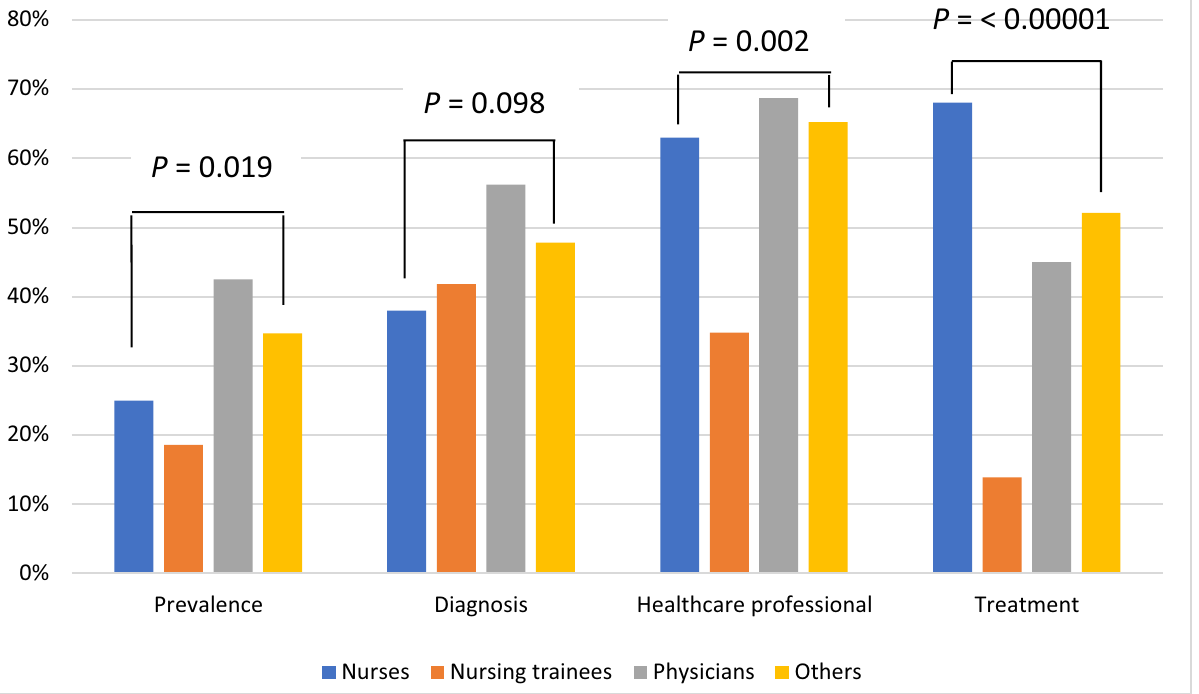
Figure 2. Knowledge about diagnosis and treatment. This area was explored through questions 15–18 (see Table 3 for the questions). no.